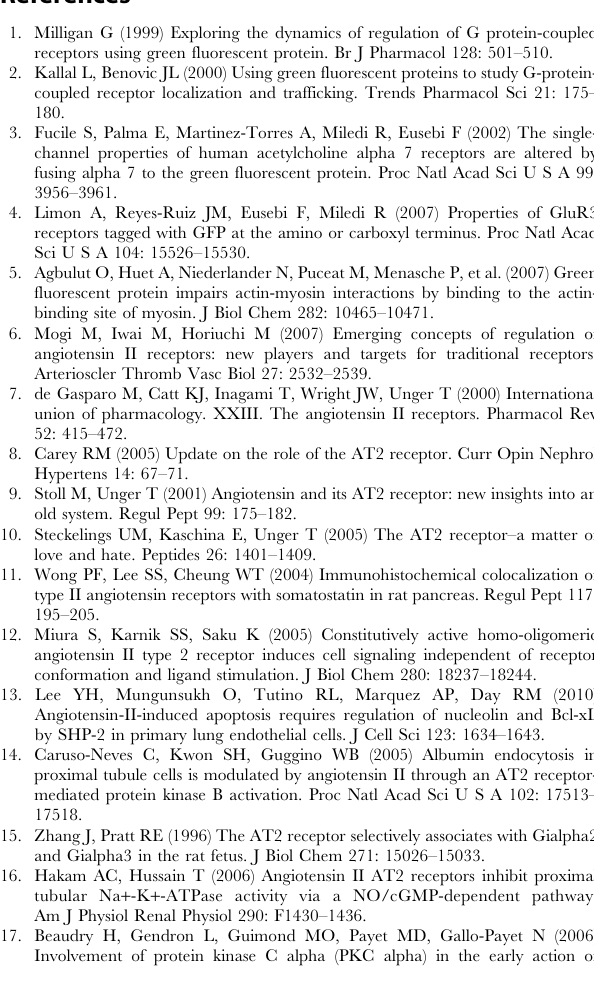
immunoreactive protein bands are indicated with asterisks. Ab